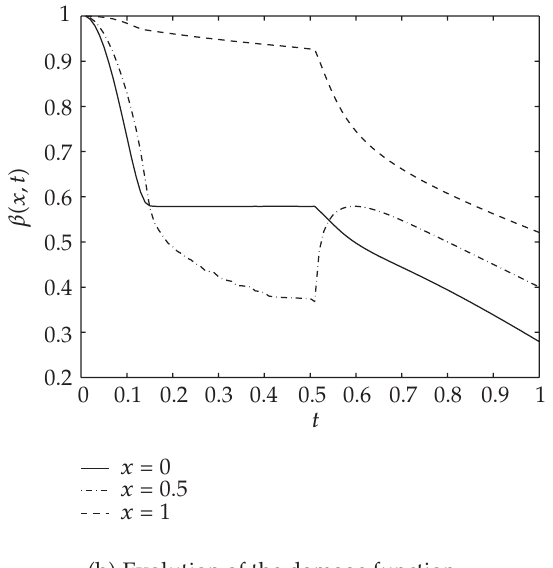
Figure 4.4 . Problem 4.1: damage function at di ff erent times and its evolution in time for several